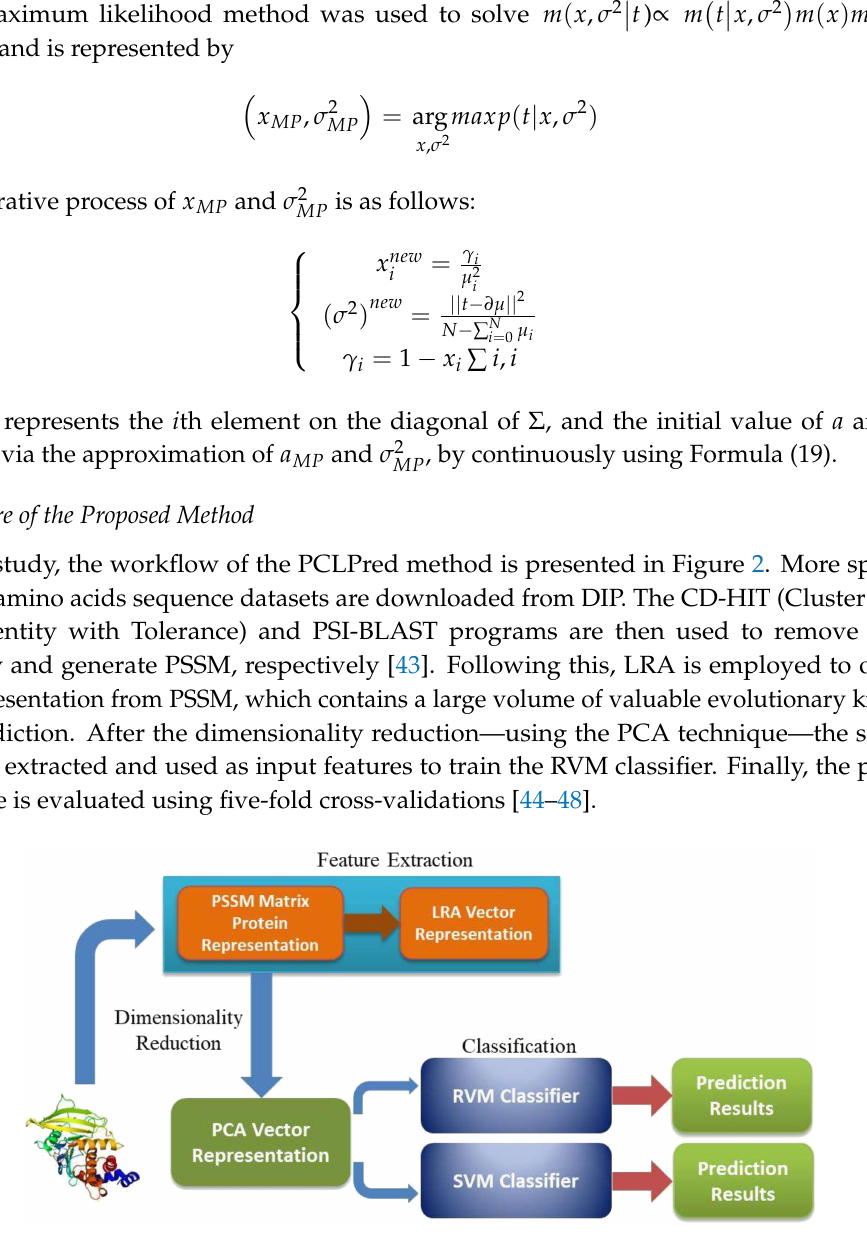
Figure 2. The flow chart of the proposed